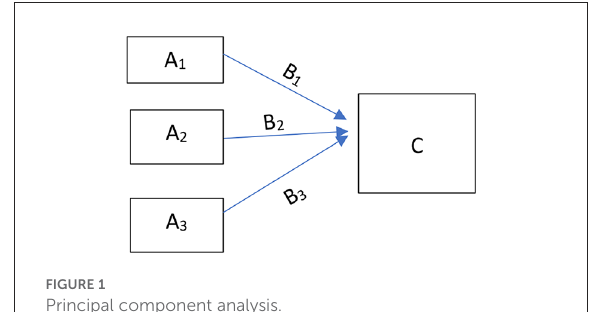
FIGURE1 Principal component